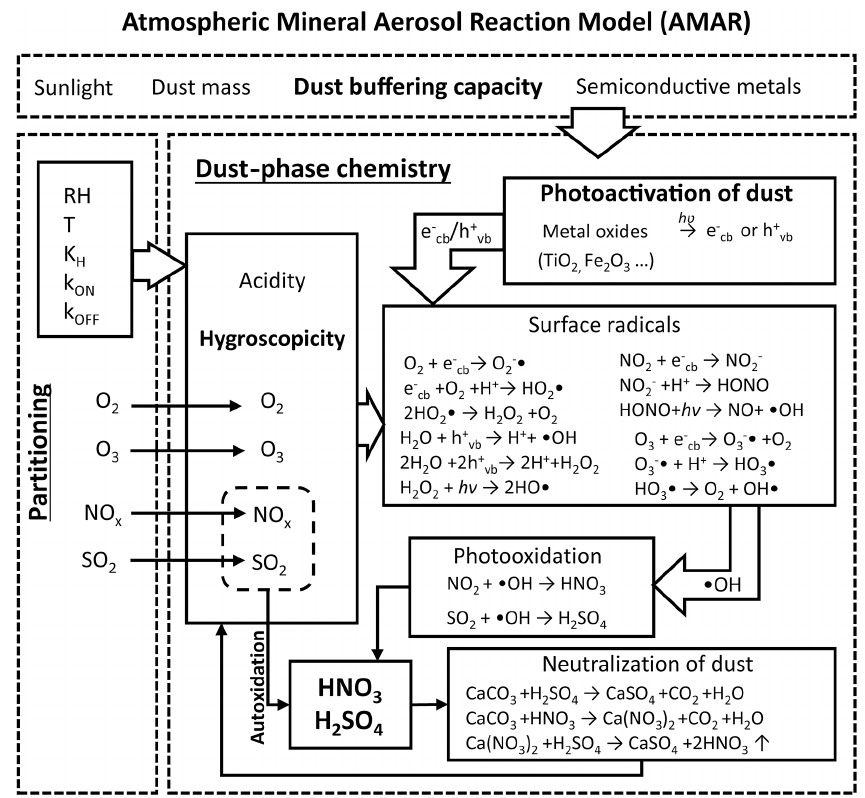
Figure 1. The overall schematic of dust phase chemistry in the AMAR